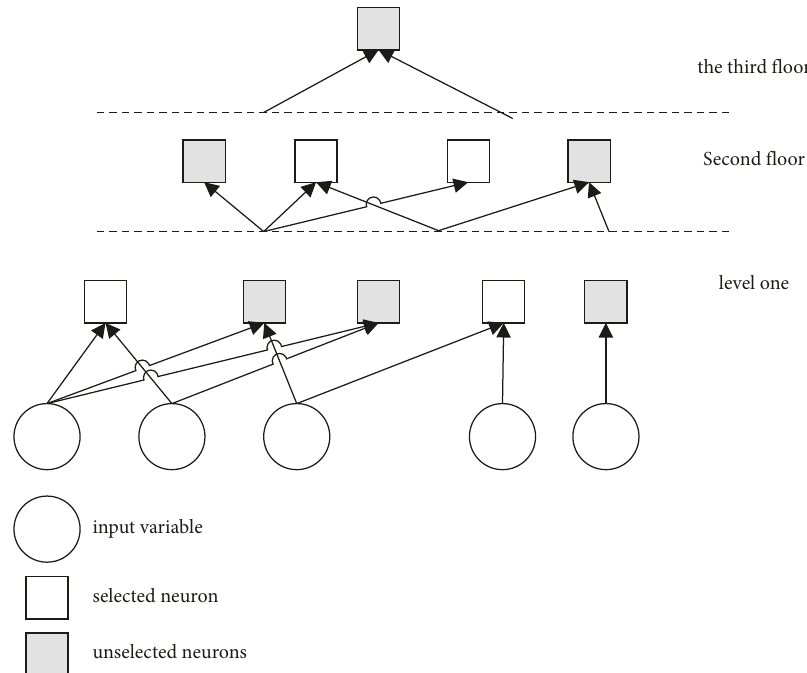
Figure 2: GMDH network